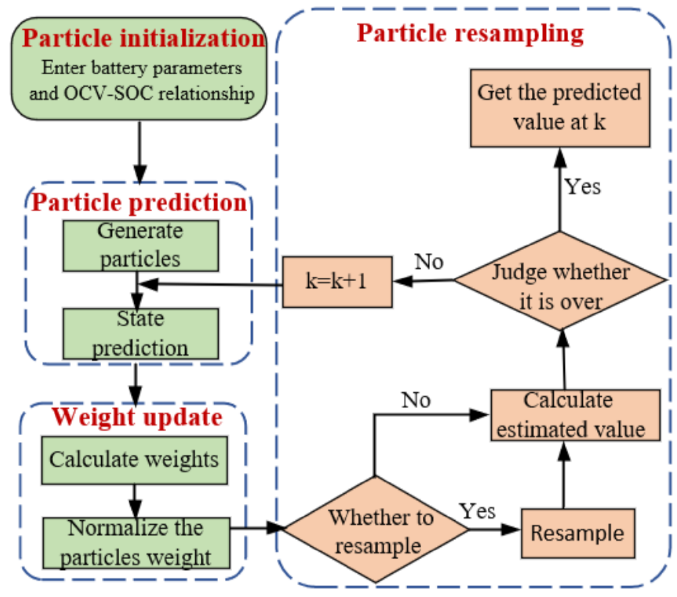
Figure 5. Structure diagram of